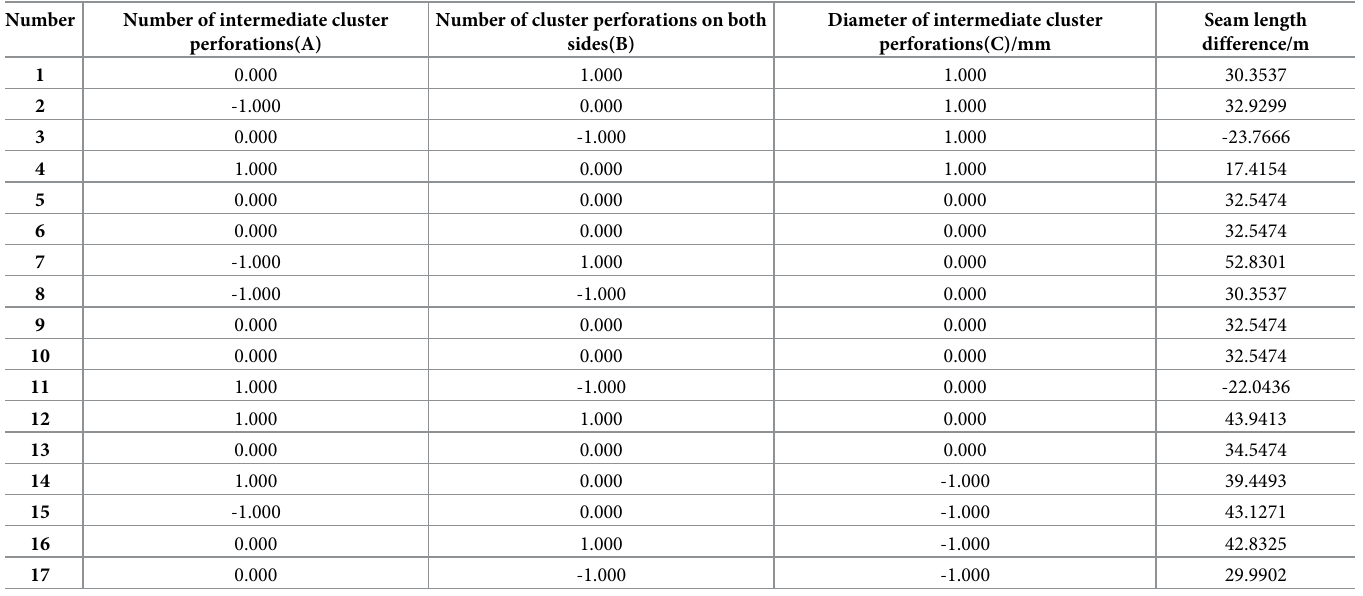
Table 3. Response surface design plan and results.